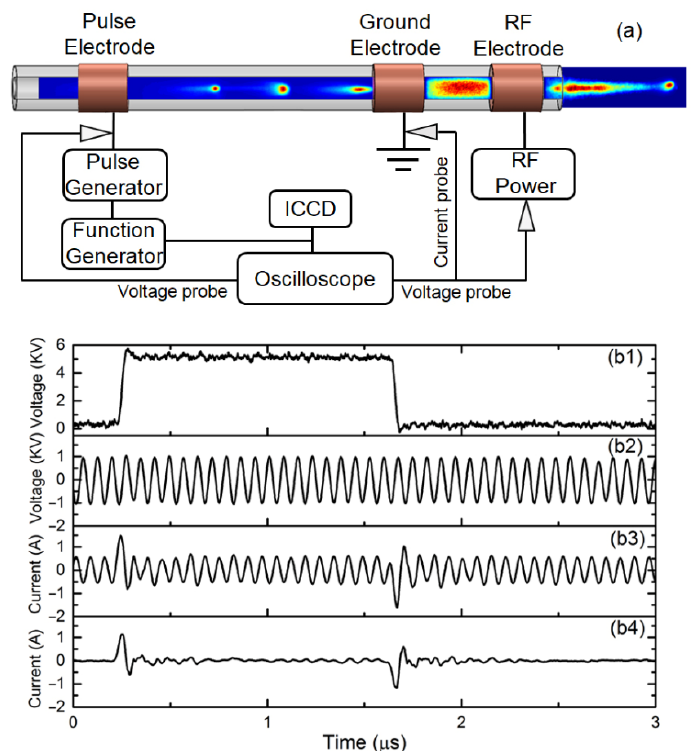
Figure 1. ( a ) Schematic of experimental setup and waveforms of ( b1 ) pulsed voltage, ( b2 ) RF voltage, ( b3 ) total discharge current, and ( b4 ) pulse discharge current. ( b3 ) total discharge current, and ( b4 ) pulse discharge